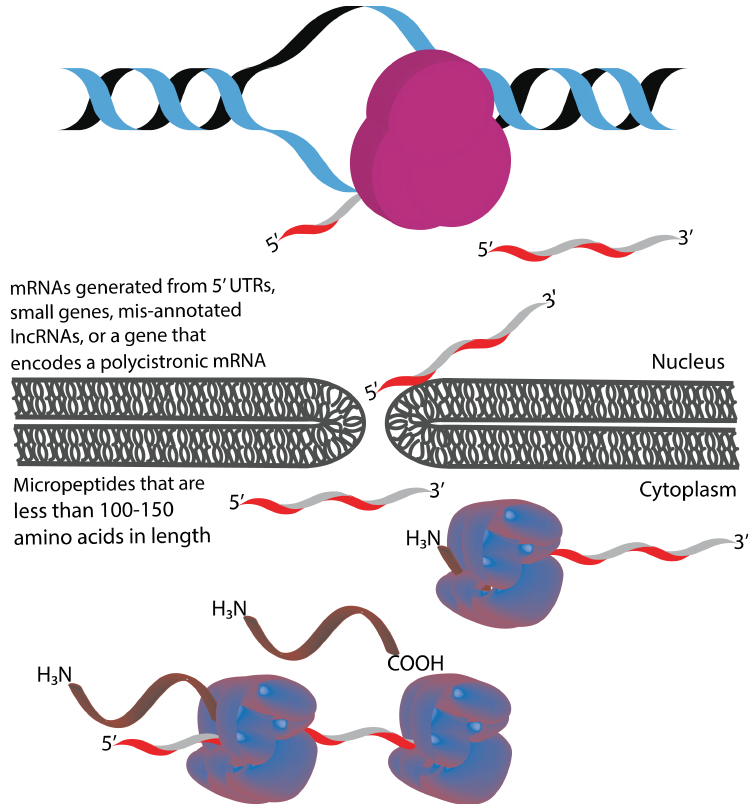
Fig 1. Genetic sources of micropeptides. Micropeptides can be transcribed from a small gene, a polycistronic mRNA, or from a lncRNA.